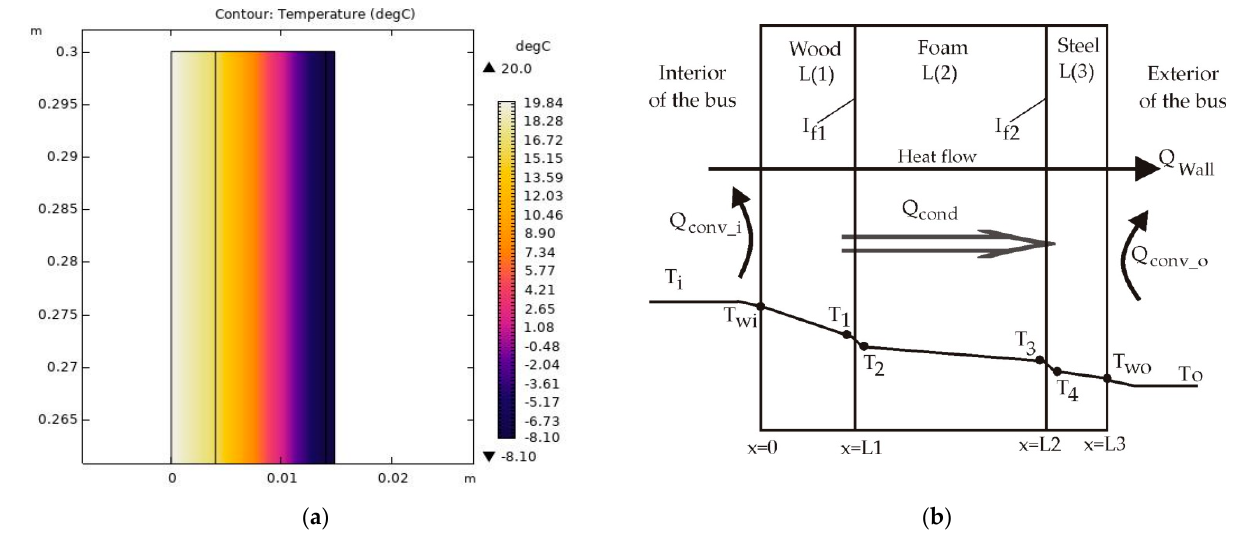
Figure 4. ( a ) Heat transfer through the wall. ( b ) Schema of the three layers of the wall of the bus.